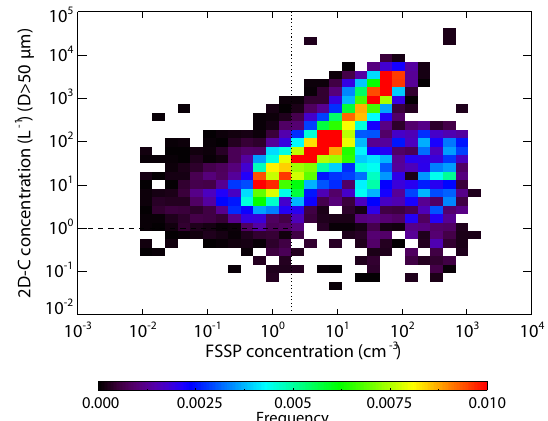
Figure 3. Occurrence distributions as a function of the particle con- centrations measured by FSSP versus the concentrations of the par- ticles ≥ 50µm in diameter measured by 2D-C in the clouds identi- fied by WCR reflectivity. The dashed and dotted lines indicate the FSSP concentration equal to 2cm − 3 and the 2D-C concentration equal to 1L − 1 ,